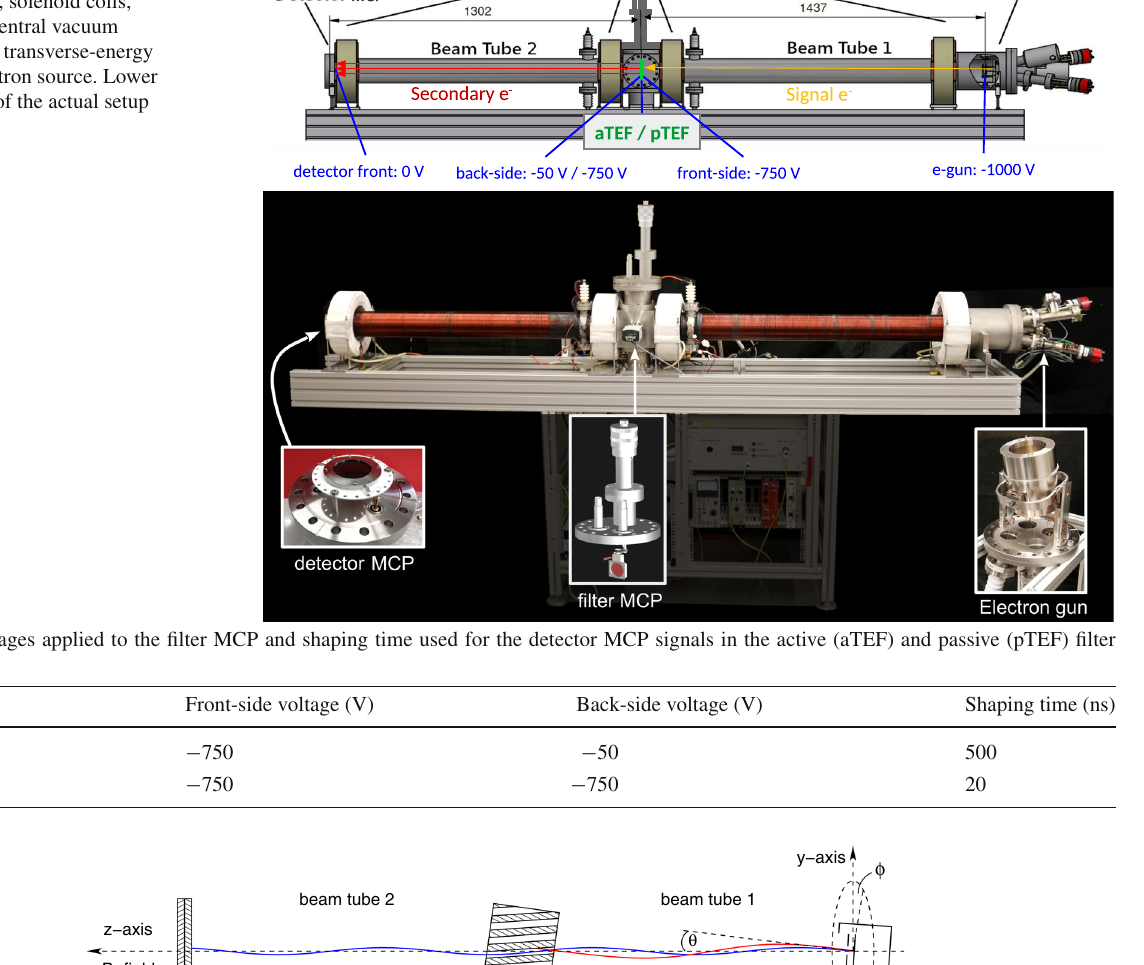
Fig. 3 Upper panel: Schematic view of the test setup with detector MCP, solenoid coils, beam tubes, central vacuum chamber with transverse-energy filter and electron source. Lower panel: Photo of the actual setup